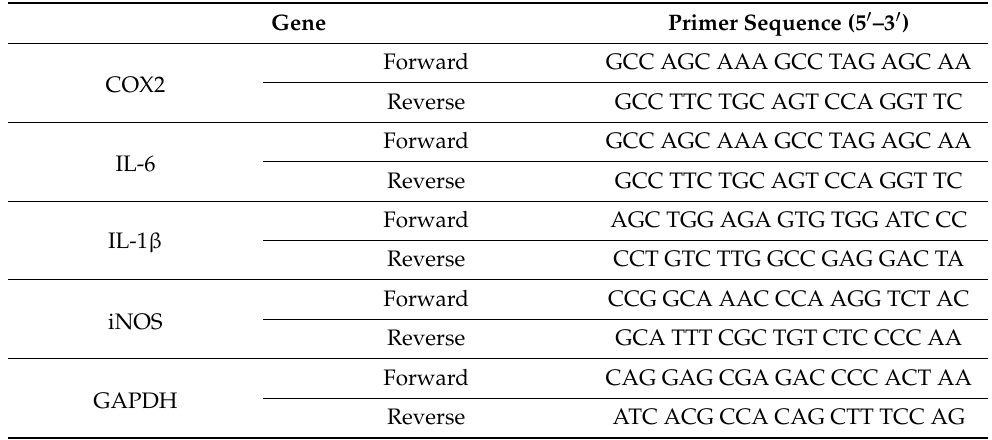
Table 1. Primer sequences for RT-PCR analysis of proinflammatory cytokines. Gene Primer Sequence (5 (cid:48) –3 (cid:48)